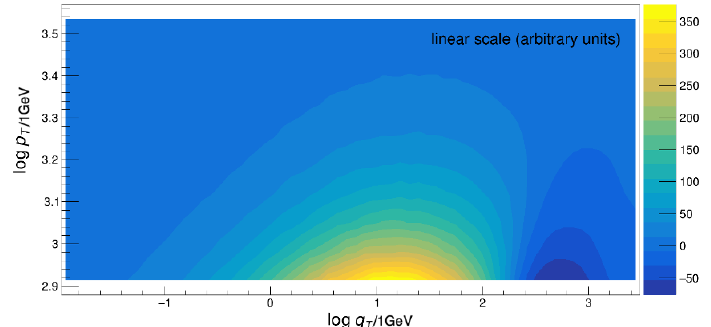
Figure 13 . The hadroproduction cross section (in arbitrary units) as a function of the transverse momentum of the vector meson p and the transverse momentum (cid:13)owing in the double-Pomeron loop q , for the kinematics probed by the CMS measurement. The deep blue region gives a negative contribution to the integral over q , but the cross section di(cid:11)erential in physically accessible variable p remains j j